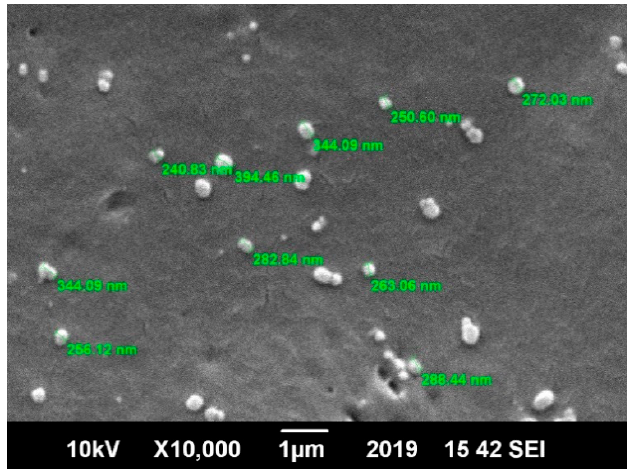
Figure 3. Scanning electron microscope (SEM) image of the polycaprolactone (PCL) polymer nanoparticles with spherical morphology and loaded with the Amphotericin B drug.